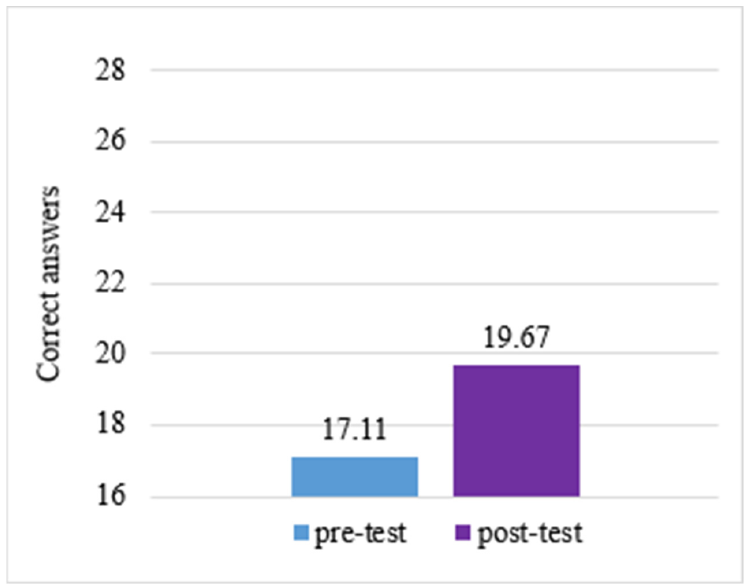
Figure 15. Fourth grade students’ mean grade in the pre-/post-test.